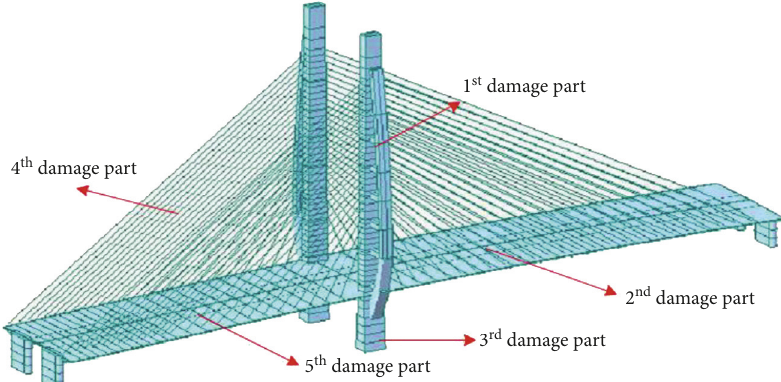
Figure 3: The layout of five damage parts in the finite element model.